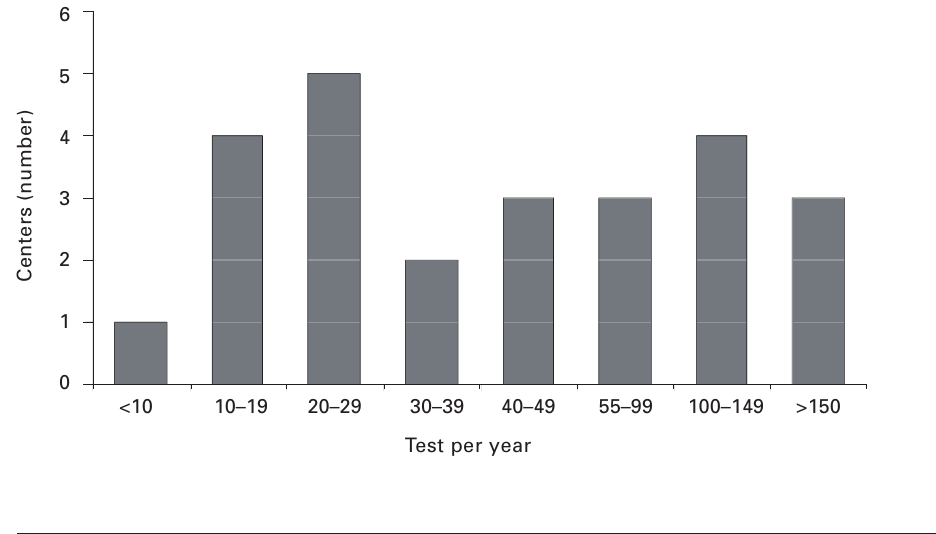
Figure 1 Tests per year per